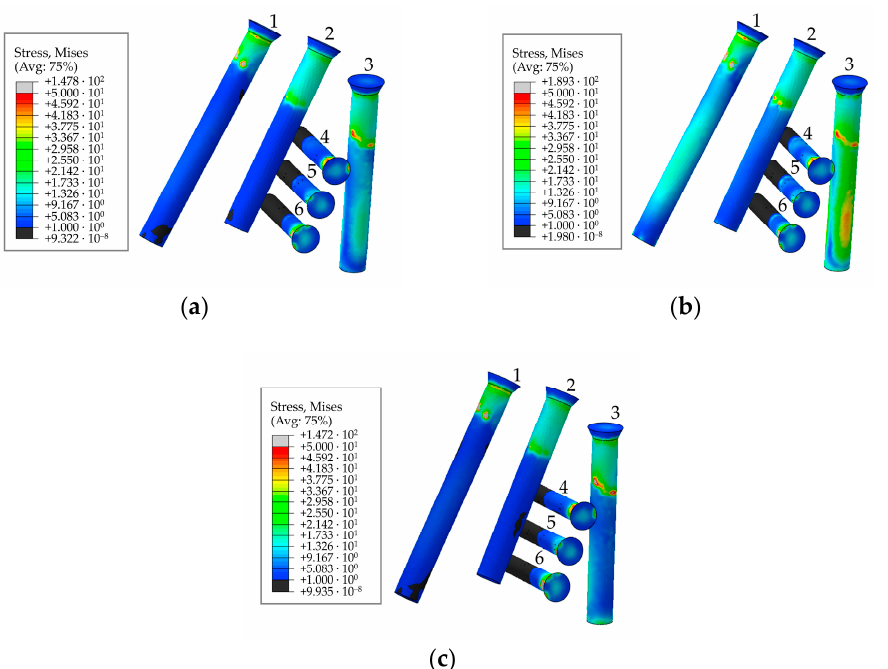
Figure 18. Stress distribution in the screws for a pretension force of 500 N and the screw numbering convention in maximum loading phases corresponding to: ( a ) walking; ( b ) ascending stairs; ( c ) descending stairs, MPa.